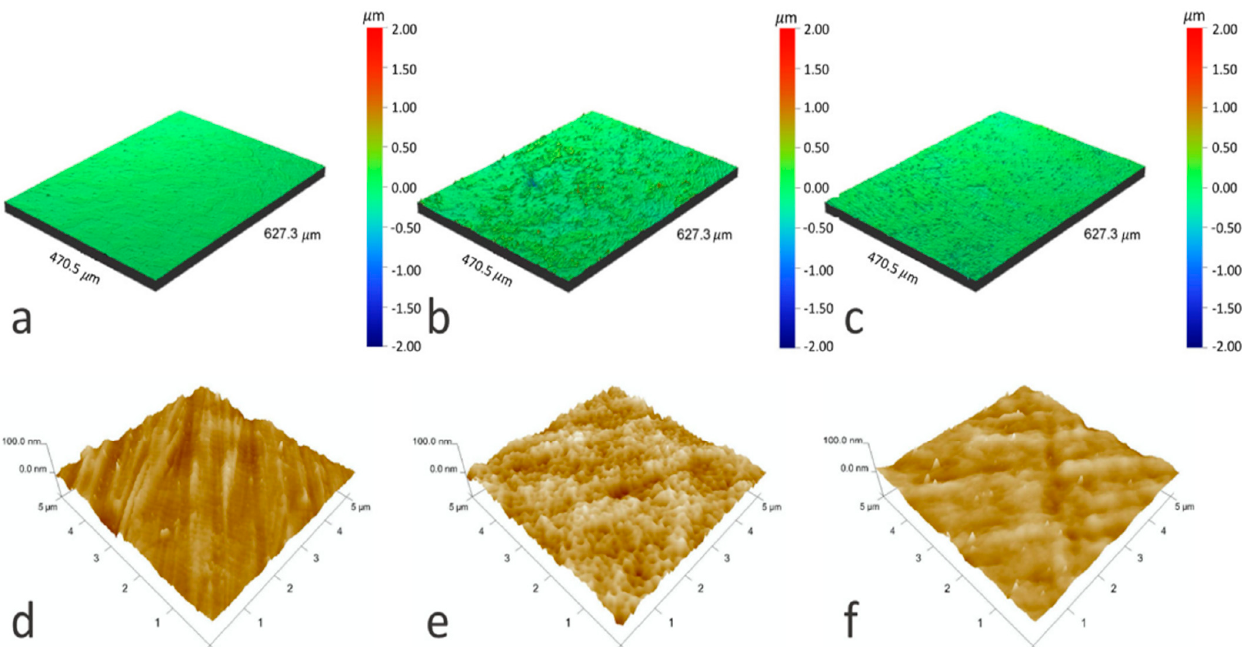
Figure 12. Photographs of the NiTi alloy texture taken with an optical profilometer ( a–c ) and an atomic force microscope (AFM) show the exterior in its initial condition, ( d ) AFM image of the plain metallic surface showing no fissures, ( e ) AFM images showing several corrosion pits and peaks (f) AFM images showing less amount of corrosion pits and peaks upon glow-discharge oxidization and RFCVD procedure. Reprinted with permission from [89]. Copyright 2021 MDPI. Distributed under Creative Commons Attribution-based license (CCBY 4.0.).